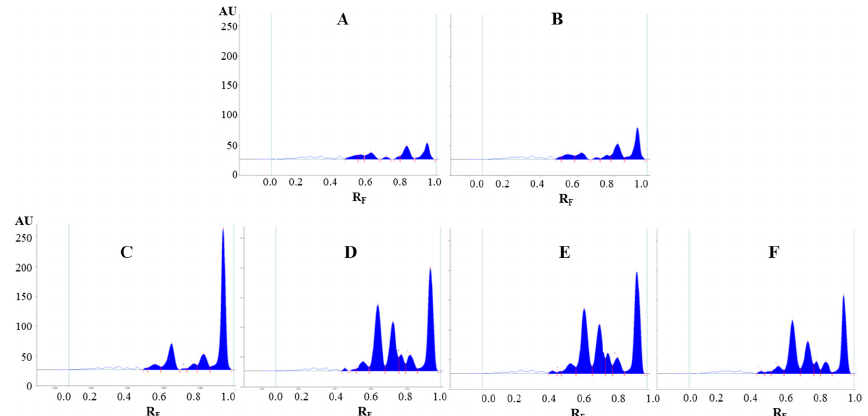
Figure 4. The densitograms of Japanese knotweed rhizomes STSs (2 µ L, 50 mg / mL) scanned at 442 nm in absorption / reflectance mode. STSs (2 µ L, 50 mg / mL) were prepared with water ( A ), 20% ethanol